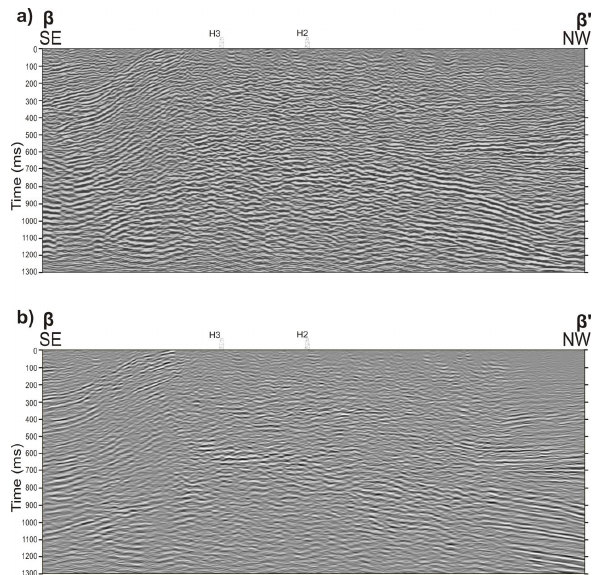
Fig. 11. (a) Migrated section (up to processing step 25 in Table 2) from α - α 0 section (location in Fig. 2) showing the main seismic fa- cies (A to H) identified, arranged in three domains; and (b) interpre- tation of section (a) , in which five main units have been recognized: Triassic, Jurassic, Lower Cretaceous, Upper Cretaceous and Ceno- zoic units. Three faults affecting the Jurassic structure have also been interpreted in this section: the Southern fault (red line), the Central fault (dark blue line) and the Eastern fault (magenta line), at inlines 1180, 1225 and 1305, respectively.